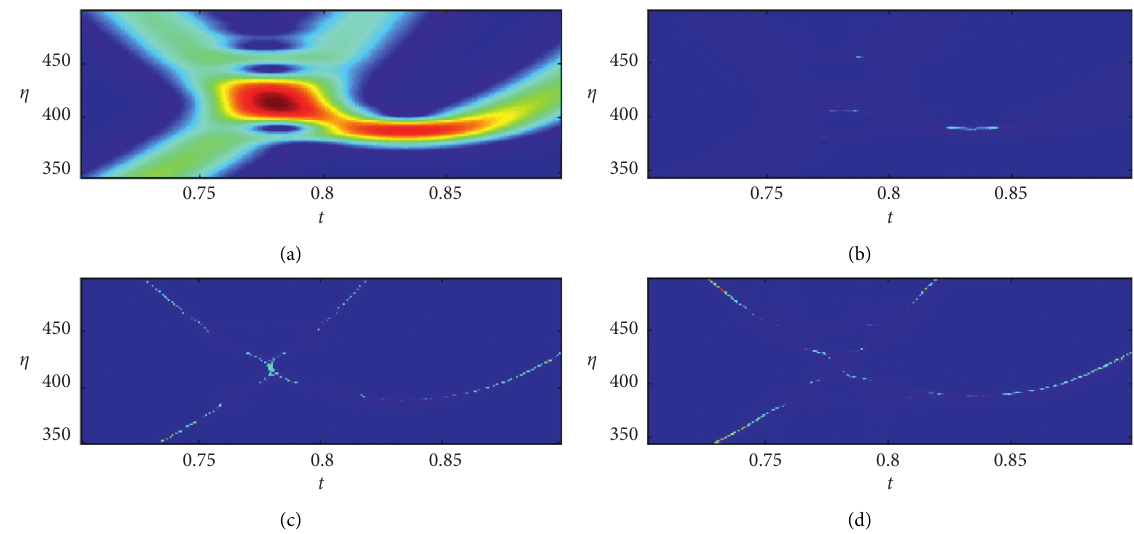
Figure 4: Local enlarged images of crossed region marked by red rectangle in Figure 2: (a) STFT, (b) FSST, (c) OSST, and (d) VSST.